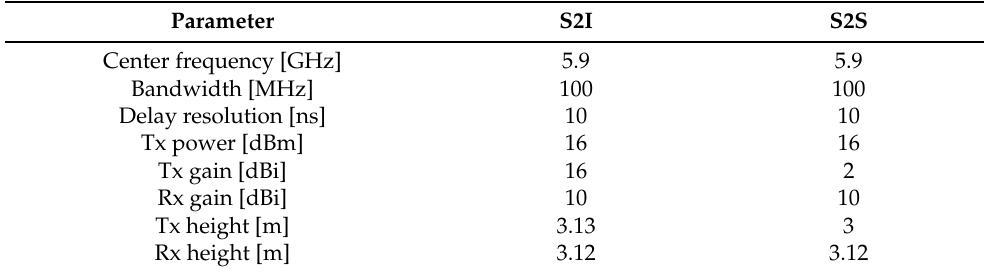
Table 1. Parameters of Measurement